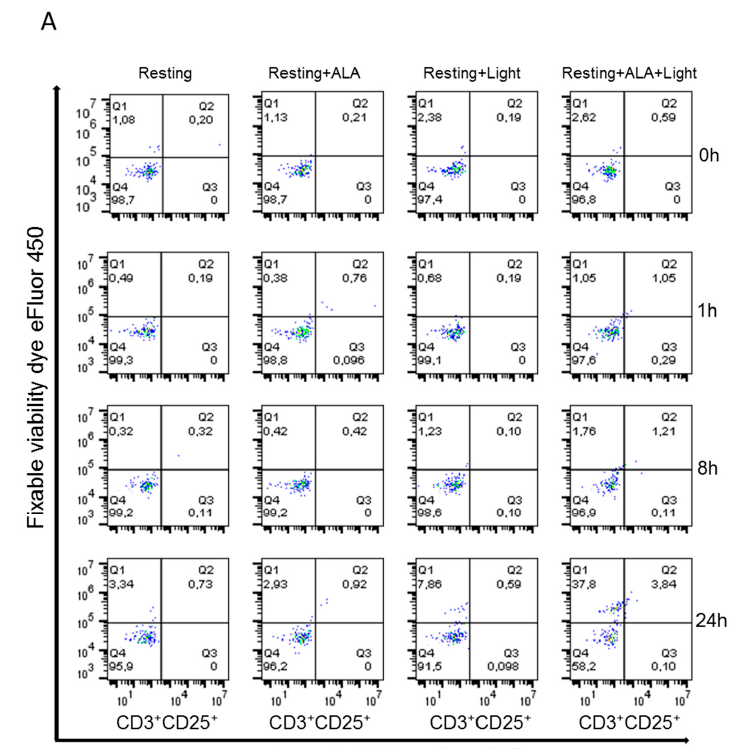
Figure 3. Cont. Figure 3.